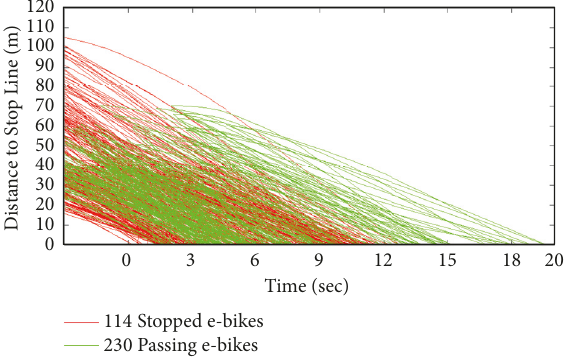
Figure 2: Observed e-bike trajectories at study